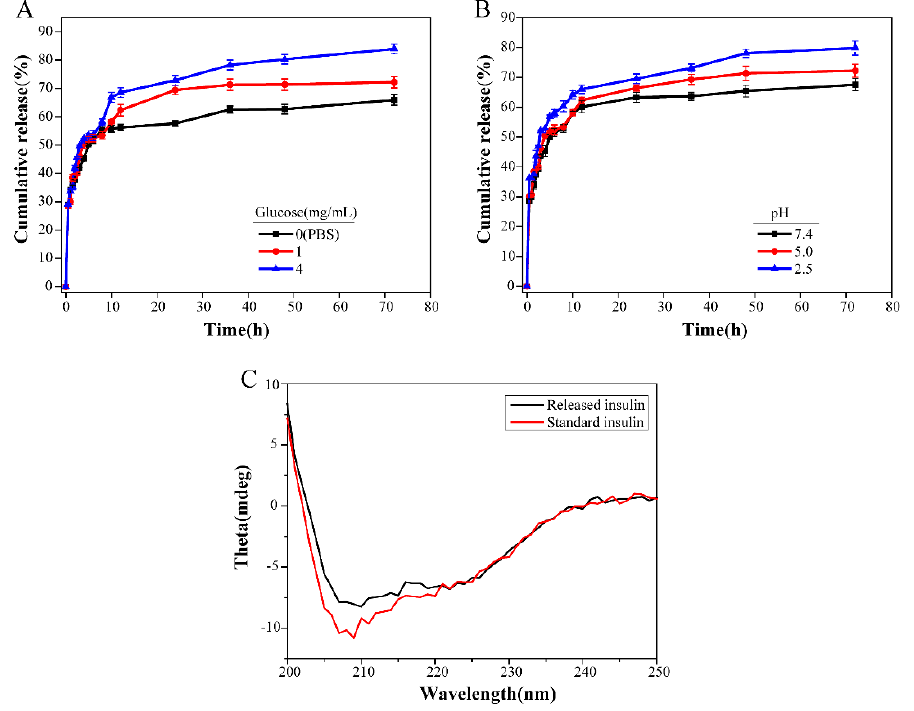
Figure 4. The degradation of hydrogels at different glucose levels ( A ) and pH ( B ).